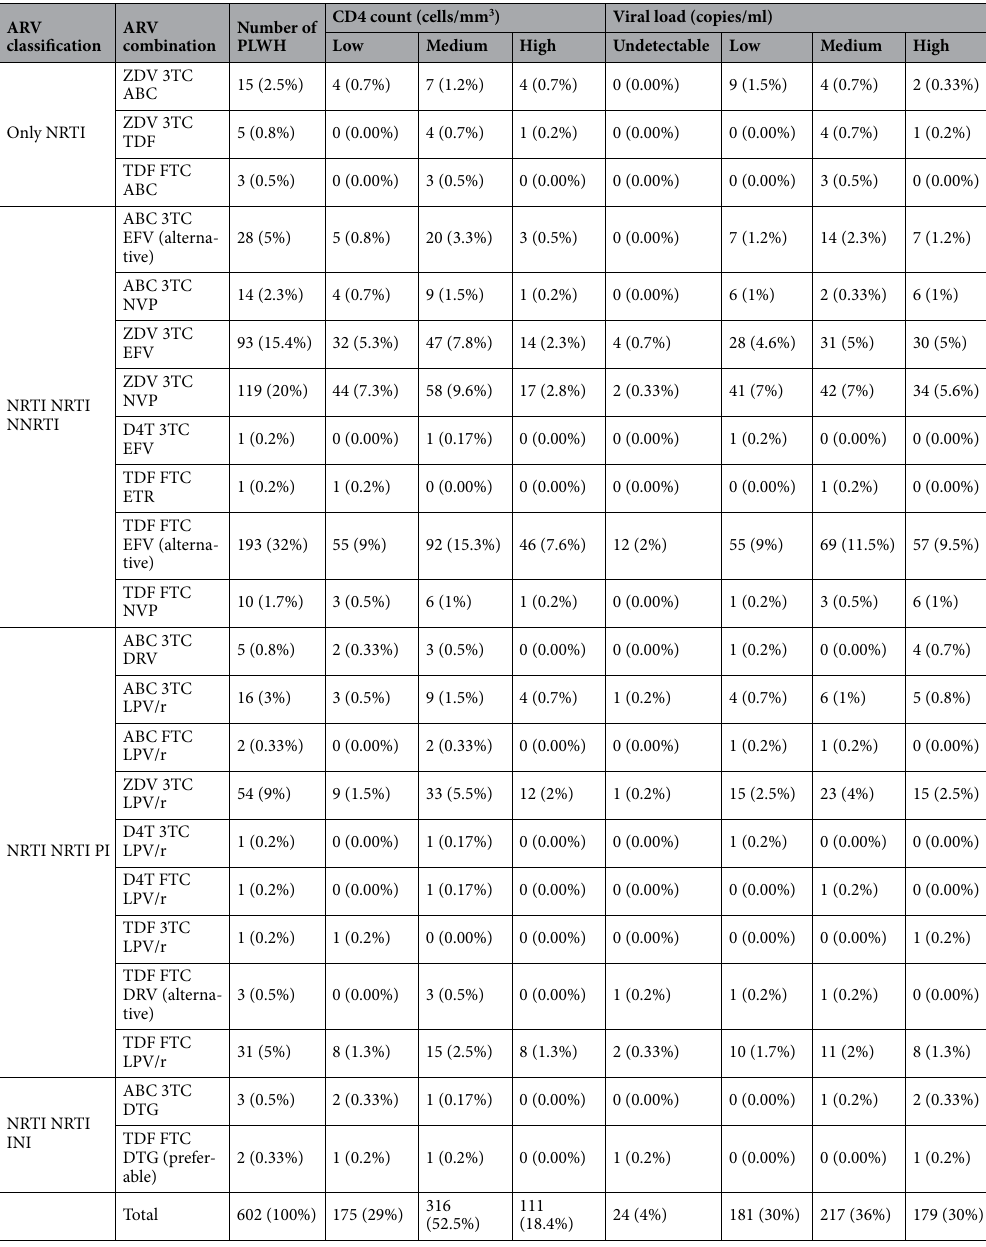
Table 2. Association between CD4 count (cells/mm3), Viral load (copies/ml) and the type of ARV combination. PI protease inhibitors, NRTI nucleoside reverse transcripts inhibitors, NNRTI non-nucleoside reverse transcripts inhibitors, INI integrase